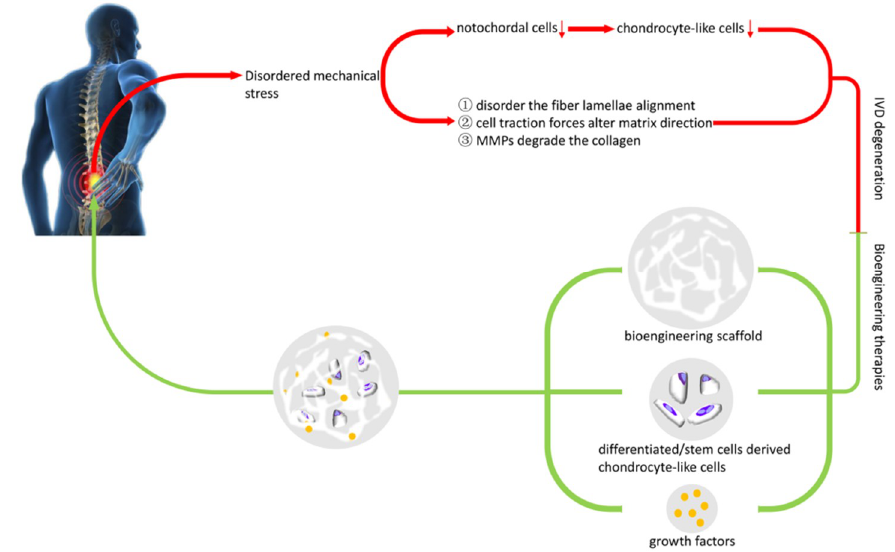
Figure 4. The role of disordered mechanical stress in IDD, and current developments in tissue- engineering